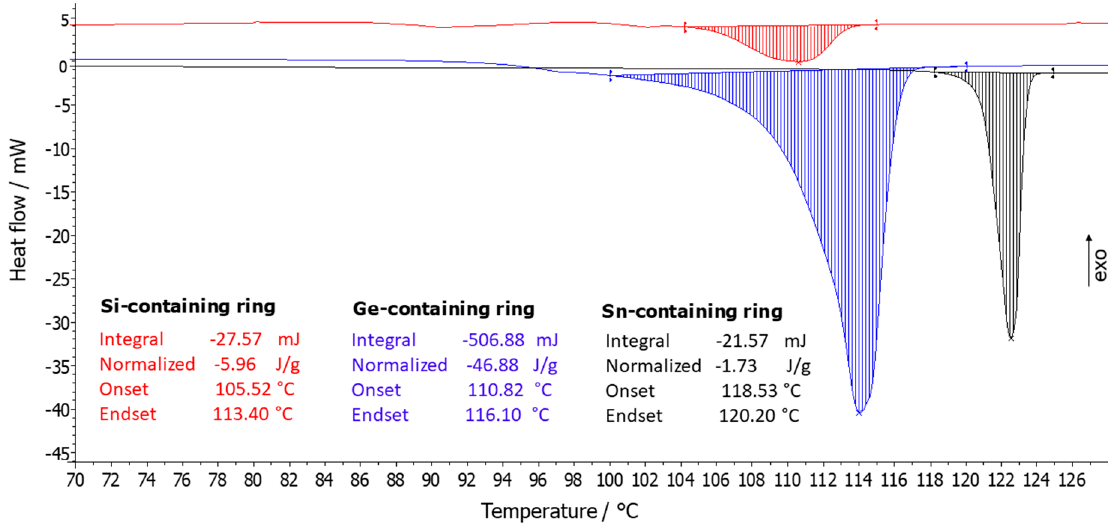
Figure 4. DSC heating scans at 10 K / min of the group 14 element ring systems (Sn-containing ring ( 9c ), Ge-containing ring ( 9b ), and Si-containing ring ( 9a )).